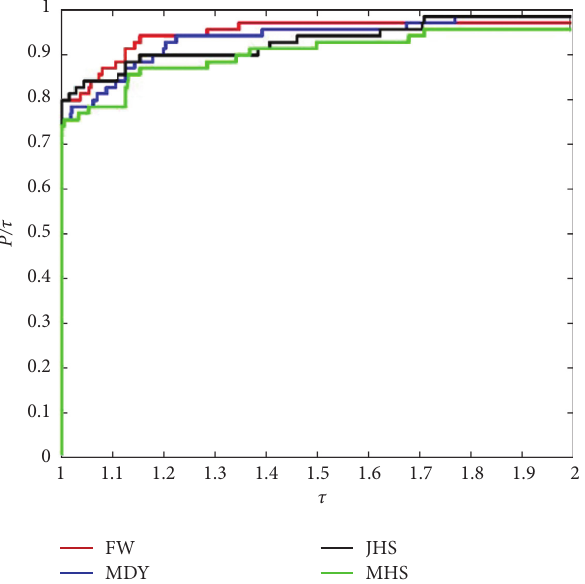
Figure 4: Performance profile on the number of iteration (FW versus MDY, JHS, and